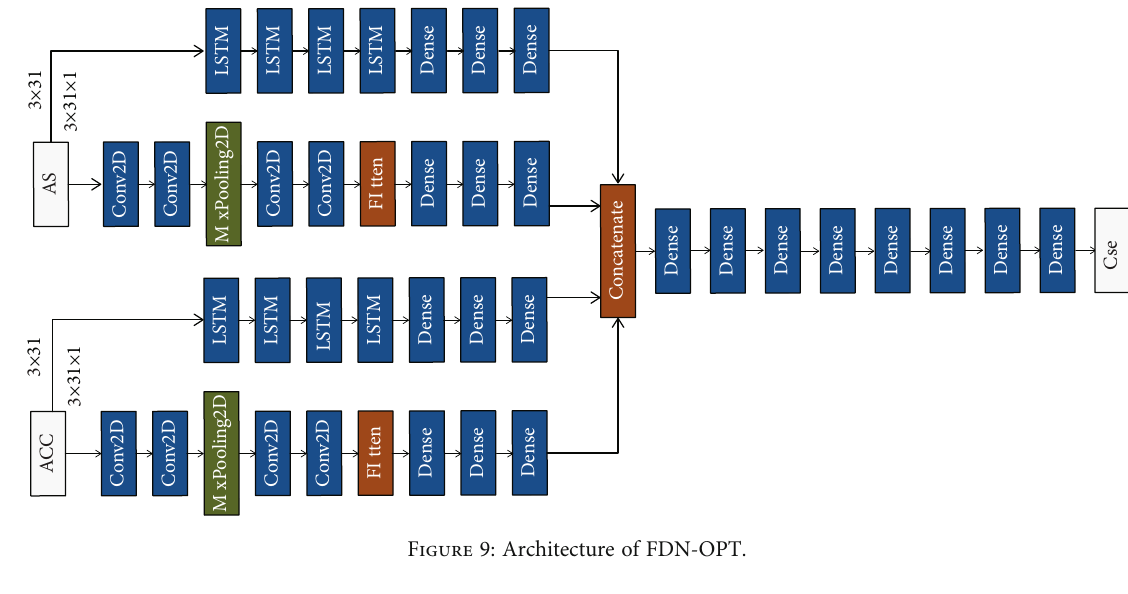
Figure 9: Architecture of